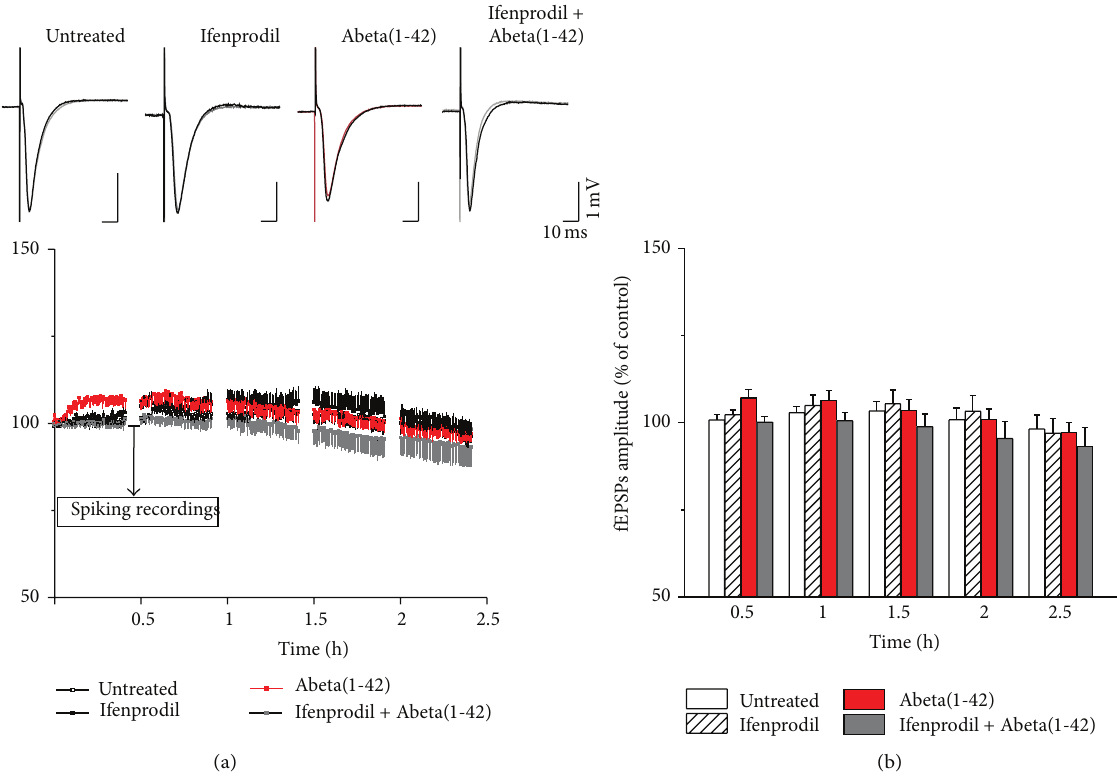
Figure 5: Neither Abeta(1-42) nor ifenprodil affects fEPSPs. Representative fEPSPs are shown before (grey) and after treatment in the upper panel. Neither Abeta(1-42) nor ifenprodil changed fEPSPs amplitudes (one-way repeated measures ANOVA with Bonferroni correction) (a). Bar graphs show the mean of the last 5 min of every recording epoch. Error bars represent SEM (b).